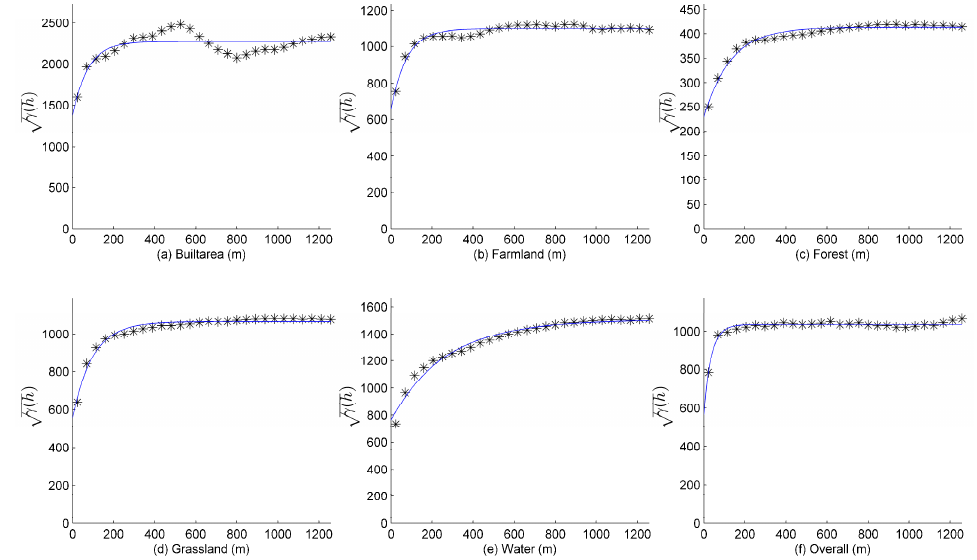
Figure 5. Semivariograms for: built area ( a ); farmland ( b ); forest ( c ); grassland ( d ); water ( e ); and overall ( f ) based on direct-analysis method (DAM).